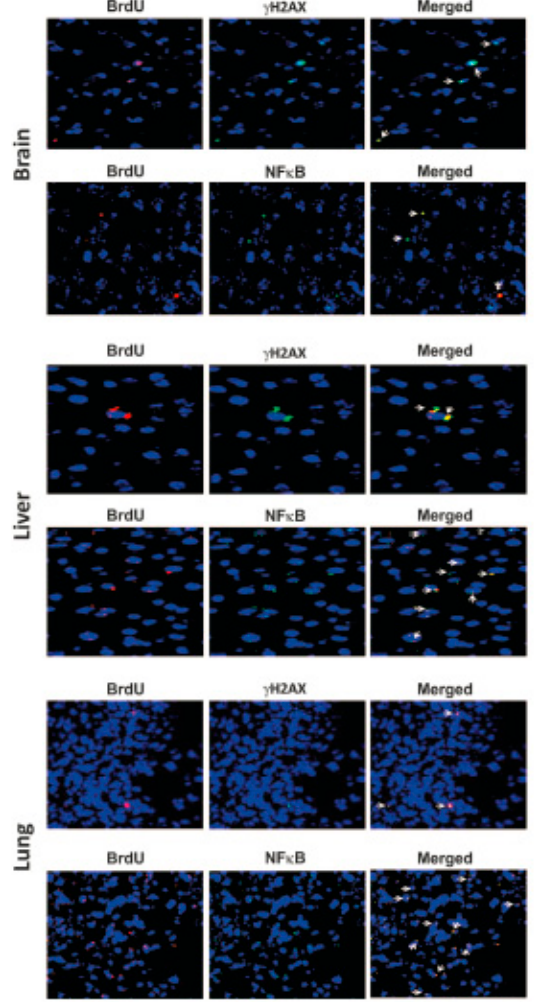
Figure 7. Co-localization of BrdU labelled fluorescent cfCh signals with those of γ H2AX and NF κ B in nuclei of cells of vital organs of mice. BrdU pre-labelled B16-F10 mouse melanoma cells were treated with Adriamycin and 10 × 10 4 dying cells were injected intravenously. Animals were sacrificed after 72 h, vital organs were immuno-stained with antibodies against γ H2AX and NF κ B and examined by fluorescence microcopy. Magnification x40. Reproduced from [83].